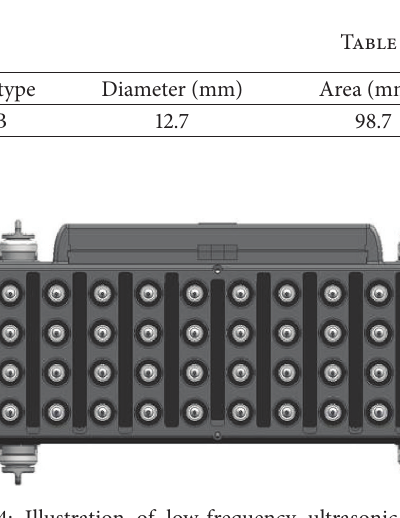
Figure 4: Illustration of low-frequency ultrasonic tomography (MIRA)